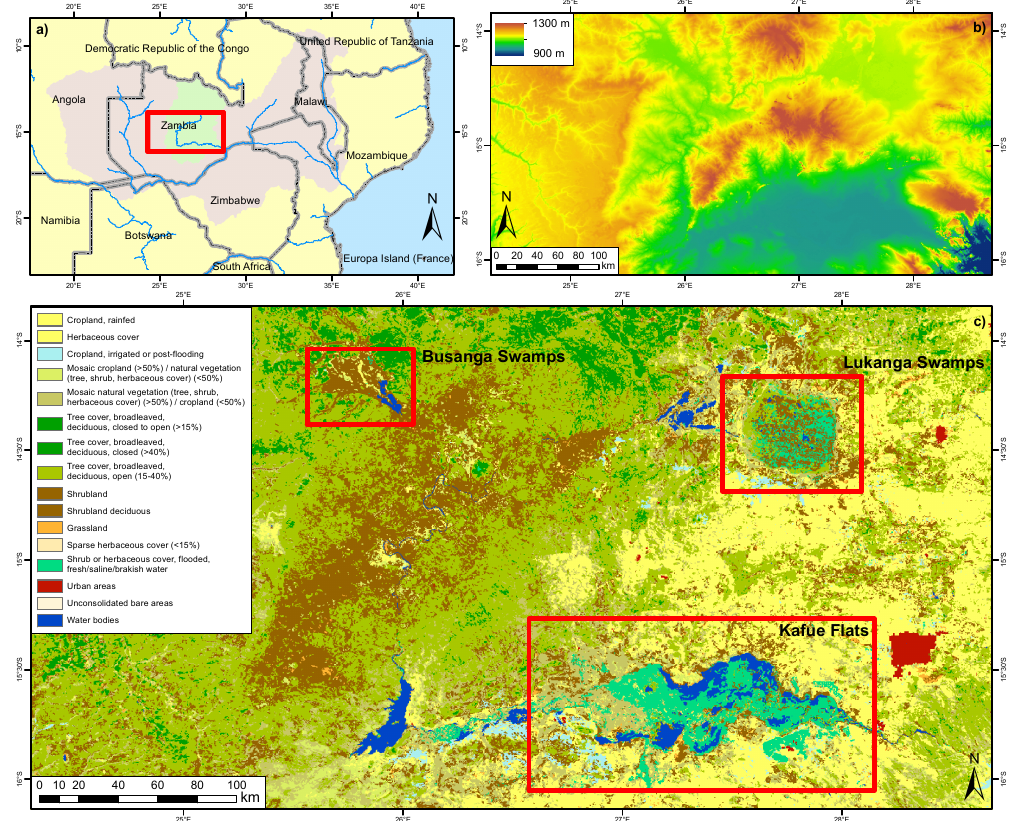
Figure 1. ( a ) Location of the study area within the Zambezi (violet) and the Kafue River (green) basins; ( b ) digital elevation model of the study area (Source: Shuttle Radar Topography Mission [40]); ( c ) land cover ( c (cid:13) ESA Climate Change Initiative—Land Cover project 2014, version 1.4 [37]).